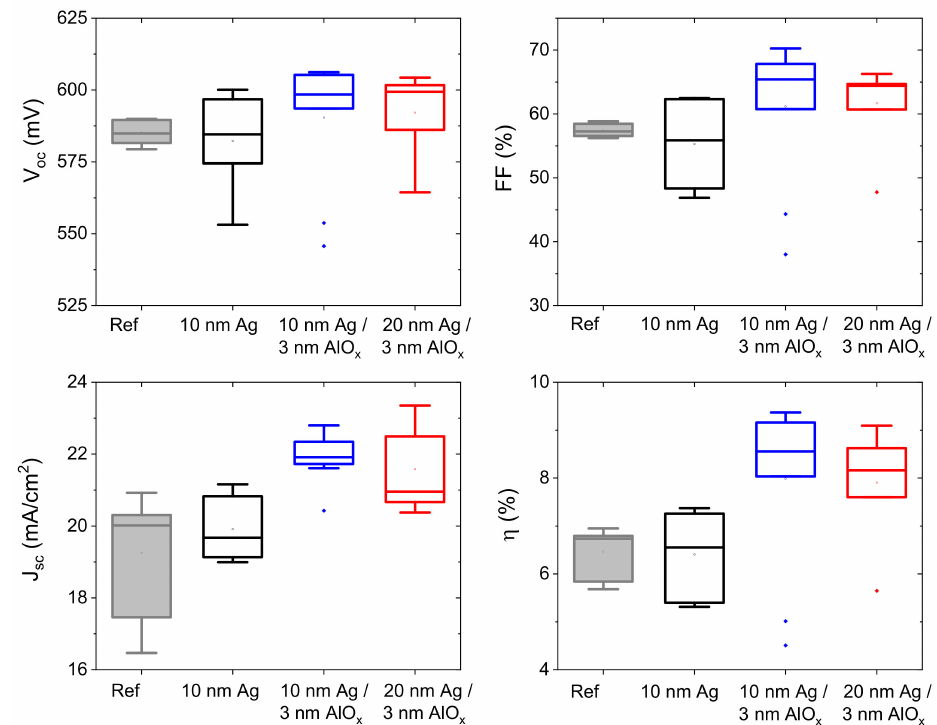
Figure 2. JV parameters of Ag-incorporated CIGS solar cells with and without AlO x . Additionally, an ultrathin three-stage solar cell without Ag is presented. ( Top left ) Voc; ( top right ) FF; ( bottom left ) Jsc; ( bottom right ) efficiency.